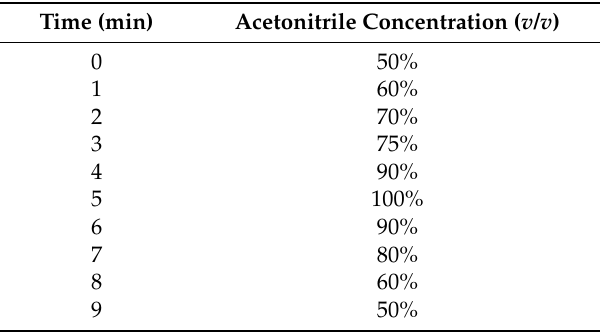
Table 1. Gradient acetonitrile